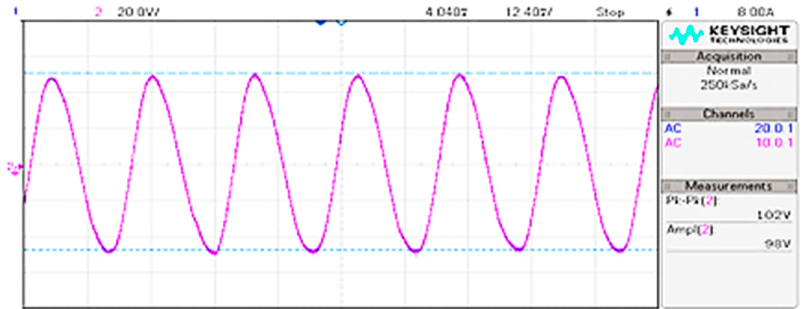
Figure 23. Phase to phase voltage across resistive load (20 Volts/Div).